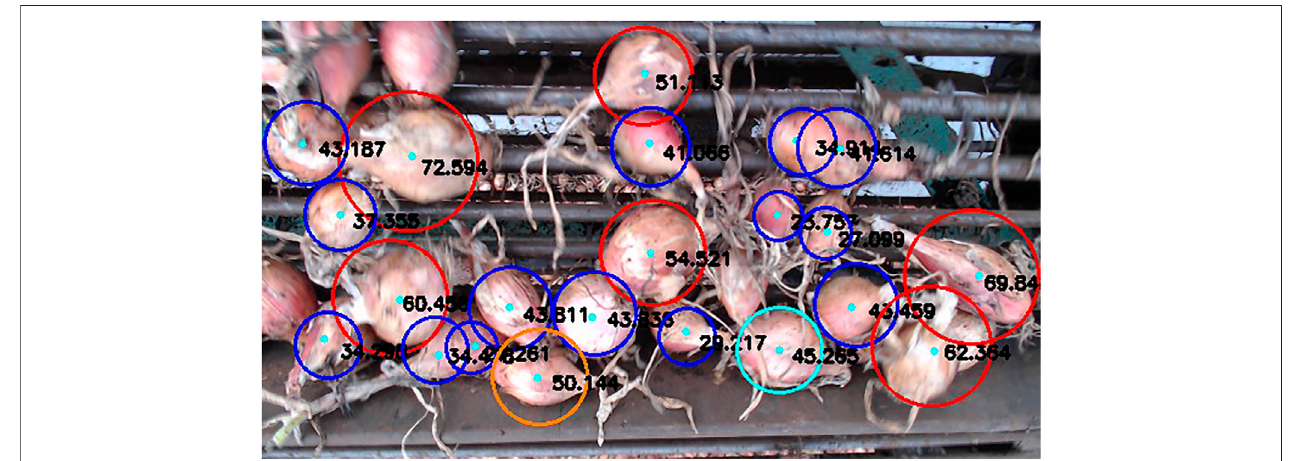
FIGURE9| Examplesofoniondetectionresultsusing k -meansclusteringofpixelsintheHSVcolorspacewith k (cid:2) 6.Predictedonionsizes(mm)aremarkeddirectly on the image.